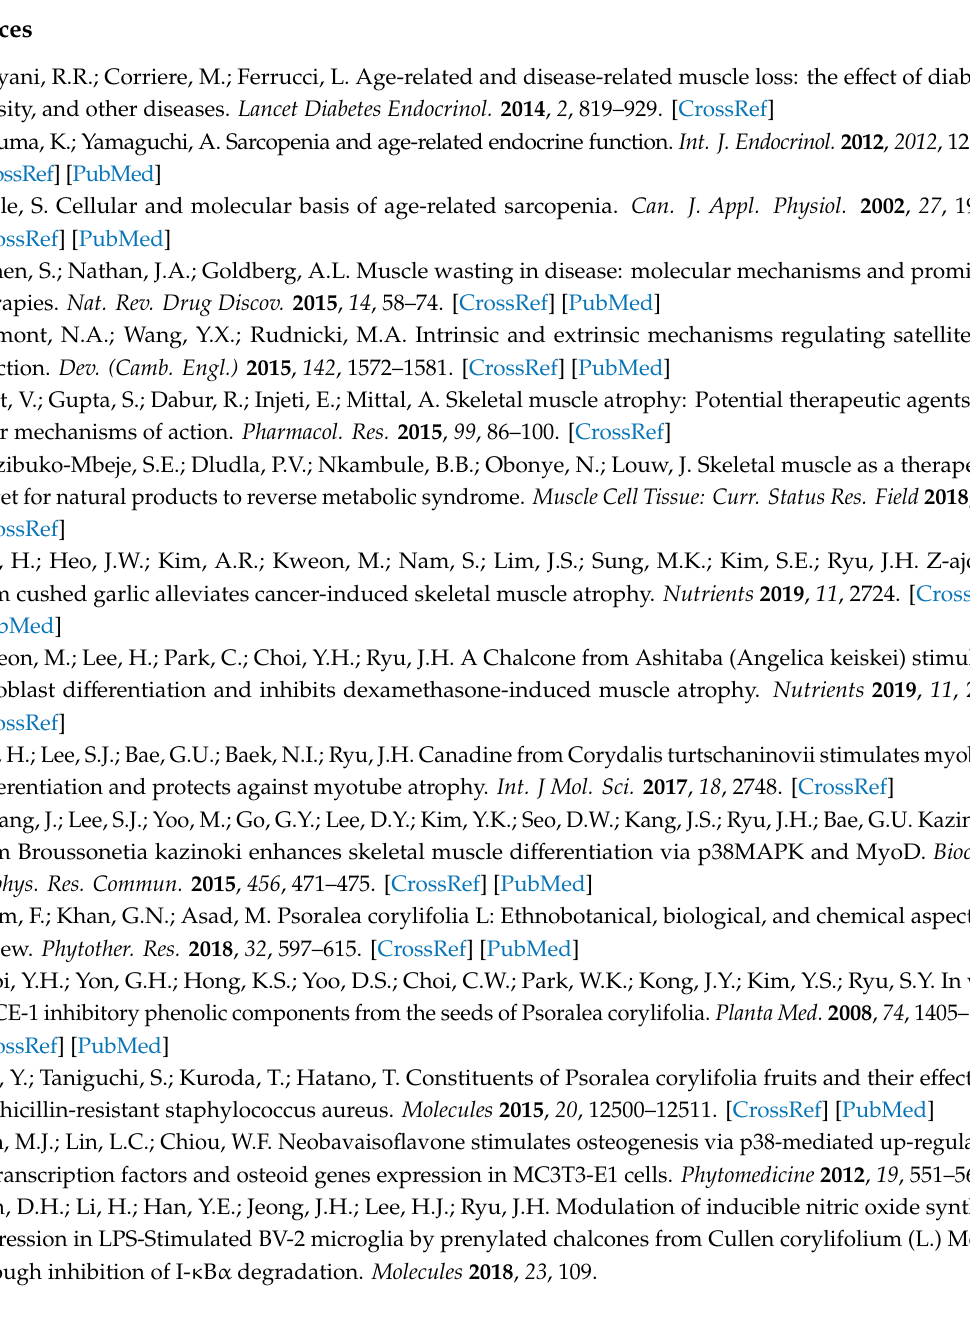
Figure S1: E ff ect of corylifol A on p38 MAPK activation during